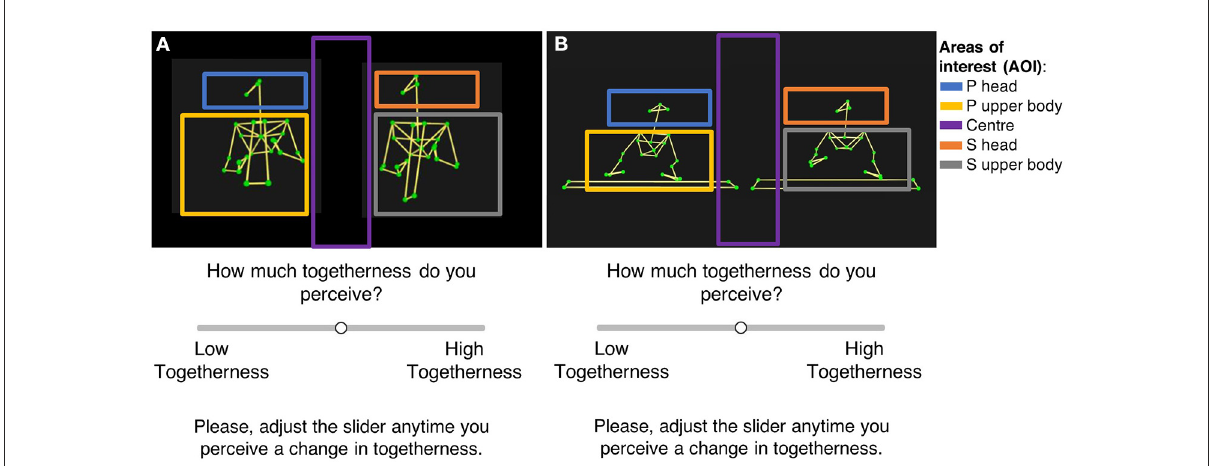
FIGURE3 Example of the perceptual task during which participants rated how much togetherness they perceived in the clarinet performances (A) and piano duo performances (B) in a sliding scale from low to high togetherness. In both displays, the Primo (P) was on the left and the Secondo (S) on the right side of the screen. The figure also displays the five areas of interest (AOI) defined for each stimulus to analyze participants’ eye-gaze during the rating task; these comprises Primo and Second head, upper body (including musicians’ arms, hands, and the instrument), and the center of the screen. The AOI markers have been added to this figure for demonstration purposes and did not appear in the videos that participants